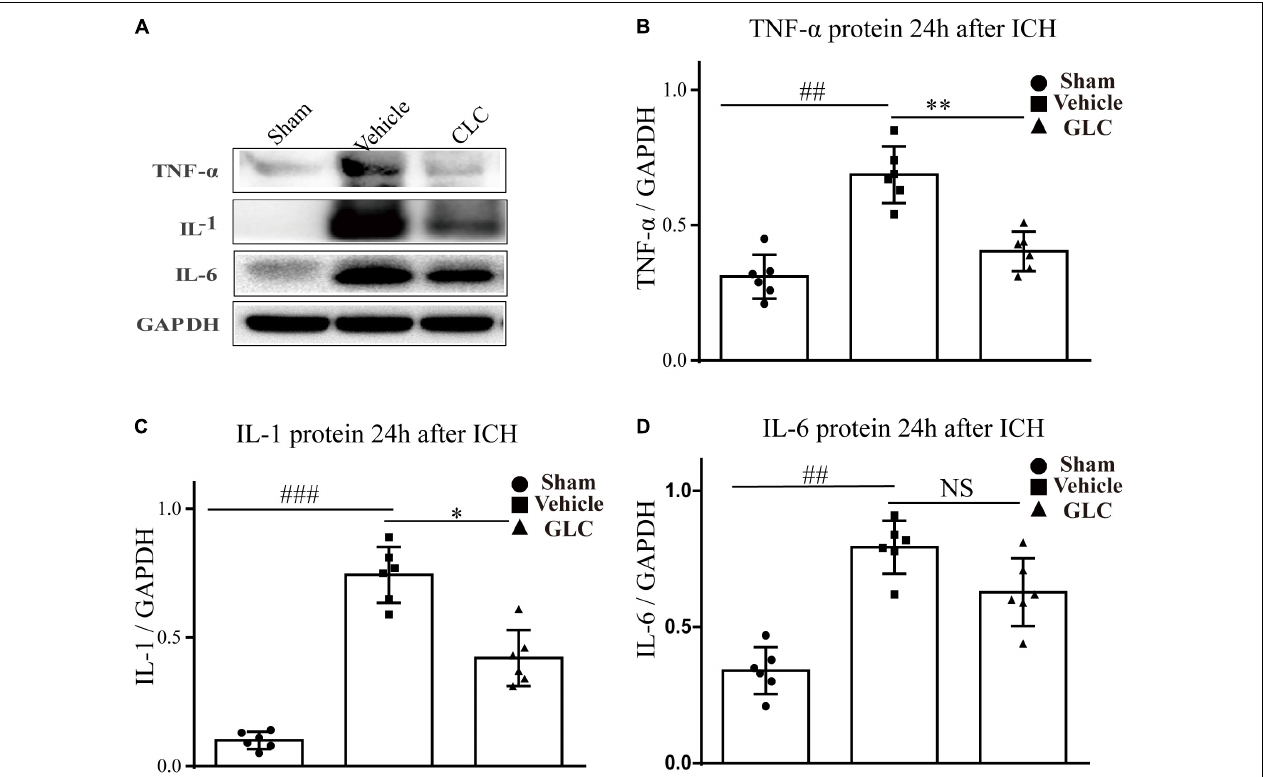
FIGURE 6 | Effect of glibenclamide (GLC) on neuroinflammation protein expression following intracerebral hemorrhage (ICH). The band intensity quantification is presented as the mean ± SD, (A,B) tumor necrosis factor (TNF)- α : vehicle vs. sham ## p < 0.01, vs. GLC ∗∗ p < 0.01; (A,C) IL-1: vehicle vs. sham ### p < 0.001, vs. GLC ∗ p < 0.05; (A,D) IL-6: vehicle vs. sham ## p < 0.01, vs. GLC p >